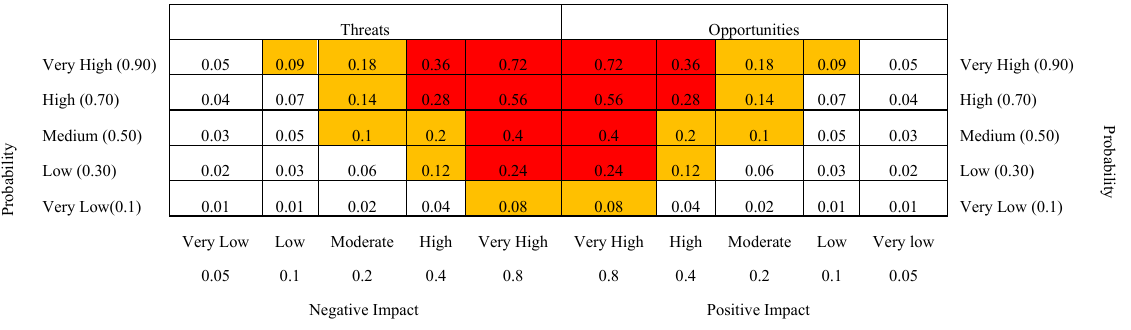
Fig. 2. Example probability and impact matrix (Source, (GUIDE, 2017; PMI, 2017 )